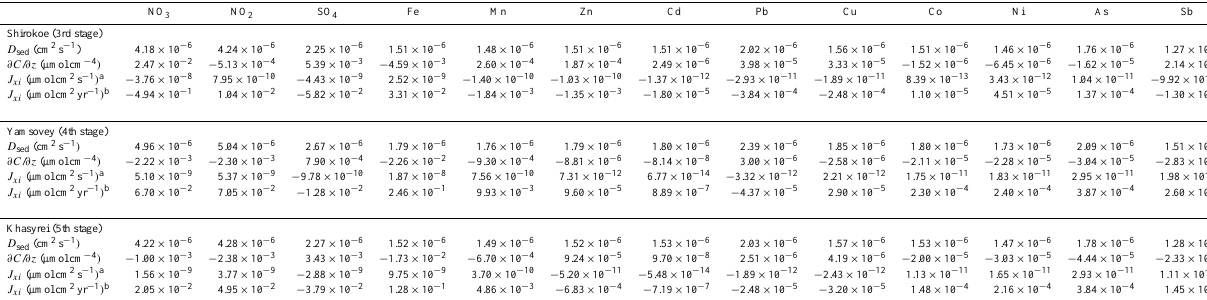
Table 4. Diffusive transport through the water-sediment interface in the three studied lakes.